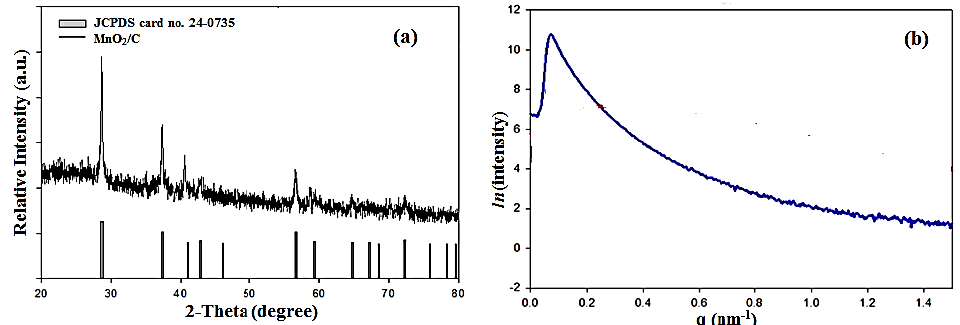
Figure 2. ( a ) Wide-angle X-ray diffraction (XRD) patterns; ( b ) small angle X-ray scattering (SAXS) patterns of MnO 2 /C composites.